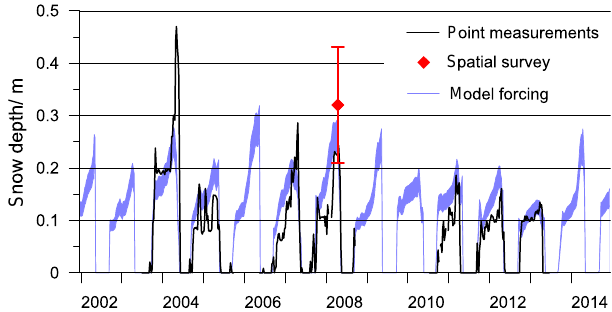
Figure 3. Modeled and measured snow depths on Samoylov Island (Boike et al., 2013). The point measurements are conducted with an ultrasonic ranging sensor (data smoothed with running average filter with window size of 1 week, corresponding to the temporal resolution of the model forcing), and the spatial survey is based on manual measurements at 216 points in polygonal tundra conducted between 25 April and 2 May 2008 (Fig. 6a, Boike et al., 2013). The blue area depicts the spread between model runs with snow densities of 200 and 250kgm − 3